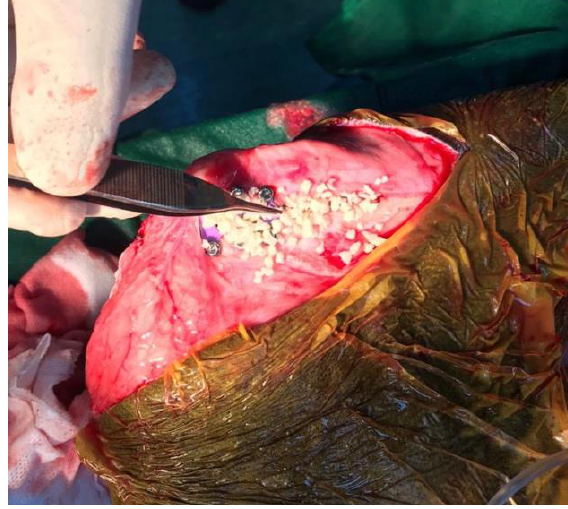
Figure 1. Tricalcium phosphate granules as osteoconductive material used to fill the spaces in the osteotomy gap.